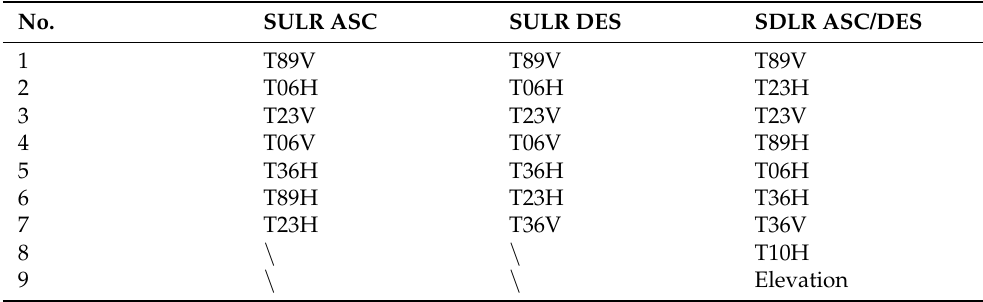
Figure 5. Histograms of the feature importance of surface upward/downward longwave radiation (SULR/SDLR) models based on the Shapley additive explanation (SHAP) method using daily calculation results from 2019. The blue dashed line indicates the Mean(|SHAP|) value of 5. Table 2. Optimal features for neural network (NN)-based surface upward/downward longwave radiation (SULR/SDLR) model inputs for the ascending (ASC) and descending (DES) data of the Advanced Microwave Scanning Radiometer 2 (AMSR2).